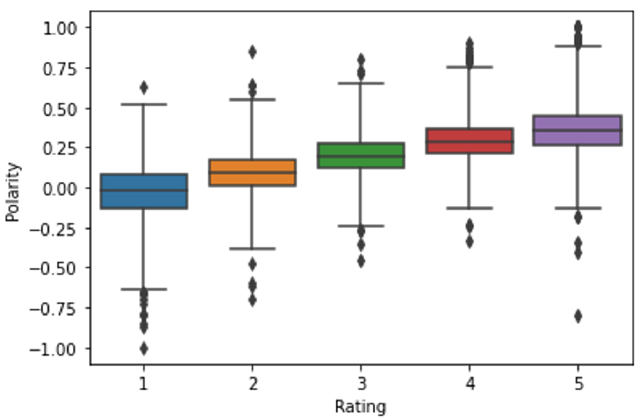
Figure 4. Correlation between “Polarity” and “Rating”.